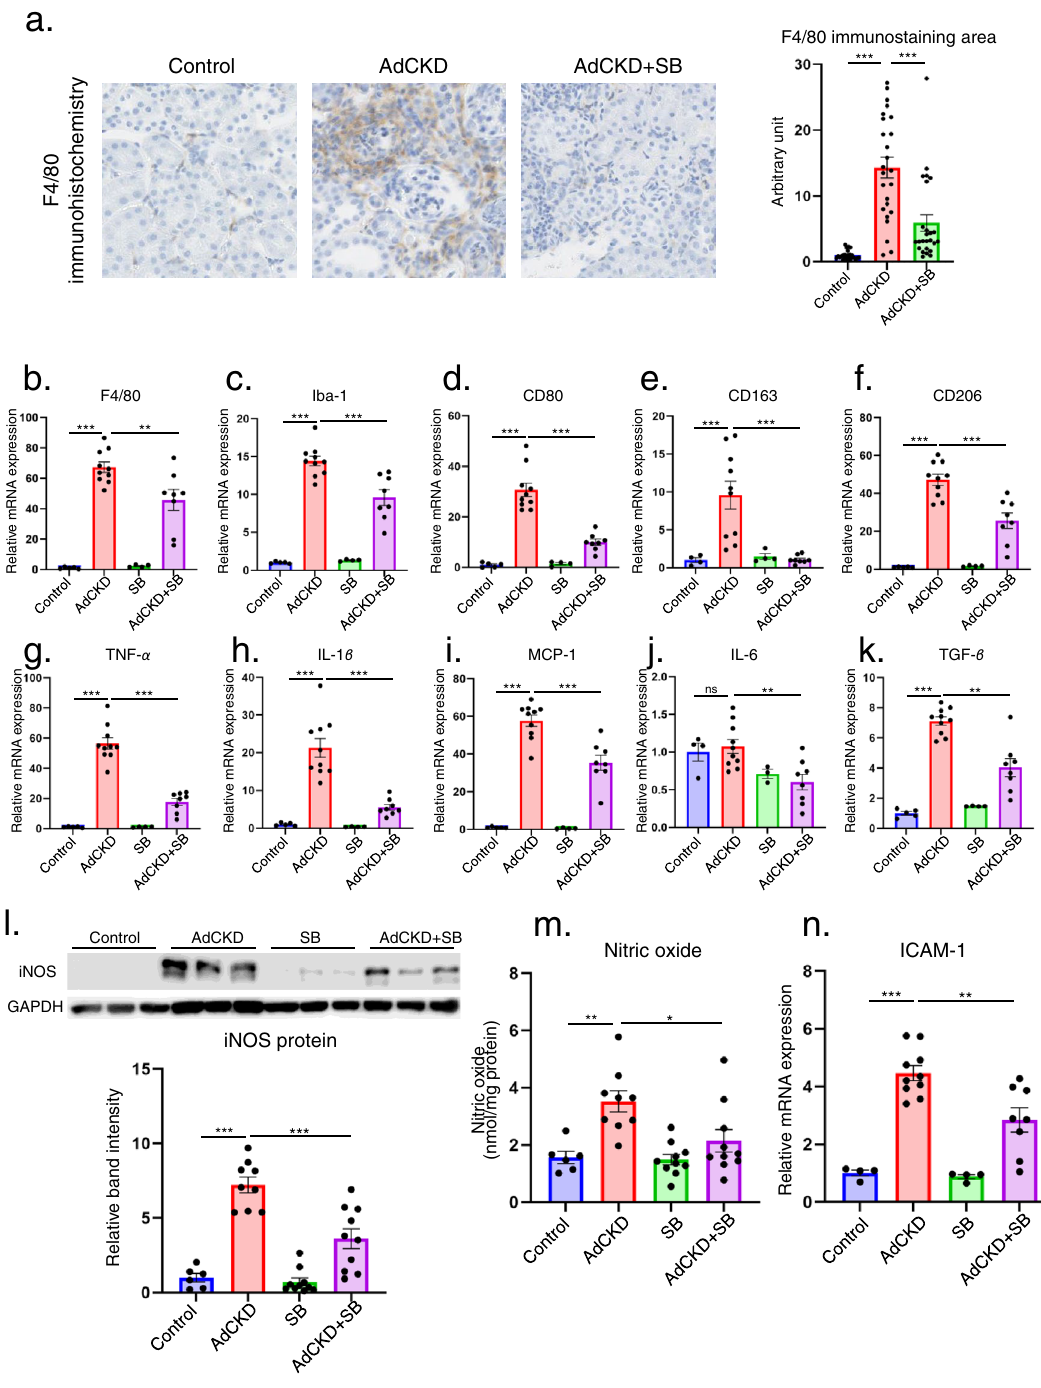
Figure 3. SB attenuated macrophage infiltration and various macrophage markers. ( a ) Plot of F4/80 immunohistochemistry staining areas of randomly acquired high-power field images. The bar graph in the right panel shows the quantifications of the stained area (n = 25 each). SB reduced relative expression of pan- macrophage markers ( b ) F4/80 and ( c ) Iba-1 , M1 macrophage markers ( d ) CD80 , ( g ) TNF-α , ( h ) IL-1β , ( i ) MCP-1 , and ( j ) IL-6 , M2 macrophage markers ( e ) CD163 , ( f ) CD206 , and ( k ) TGF-β , and contact molecule ( n ) ICAM-1 in the kidney (n = 3–10). HPRT was used as an internal control. Western blots and nitric oxide assays, respectively, showed that the abundance of the M1 macrophage marker ( l ) iNOS and ( m ) nitric oxide level was decreased following SB treatment (n = 6–10). * p < 0.05; ** p < 0.01; *** p < 0.001; ns, not significant. Each bar represents mean ± SEM. Iba-1, ionized calcium binding adaptor molecule 1; TNF-α, tumor necrosis factor α; IL-1β, interleukin-1 beta; MCP-1, monocyte chemoattractant protein-1; iNOS, inducible nitric oxide synthase; ICAM-1, intercellular adhesion molecule-1; HPRT, hypoxanthine guanine phosphoribosyl transferase; SB, sodium